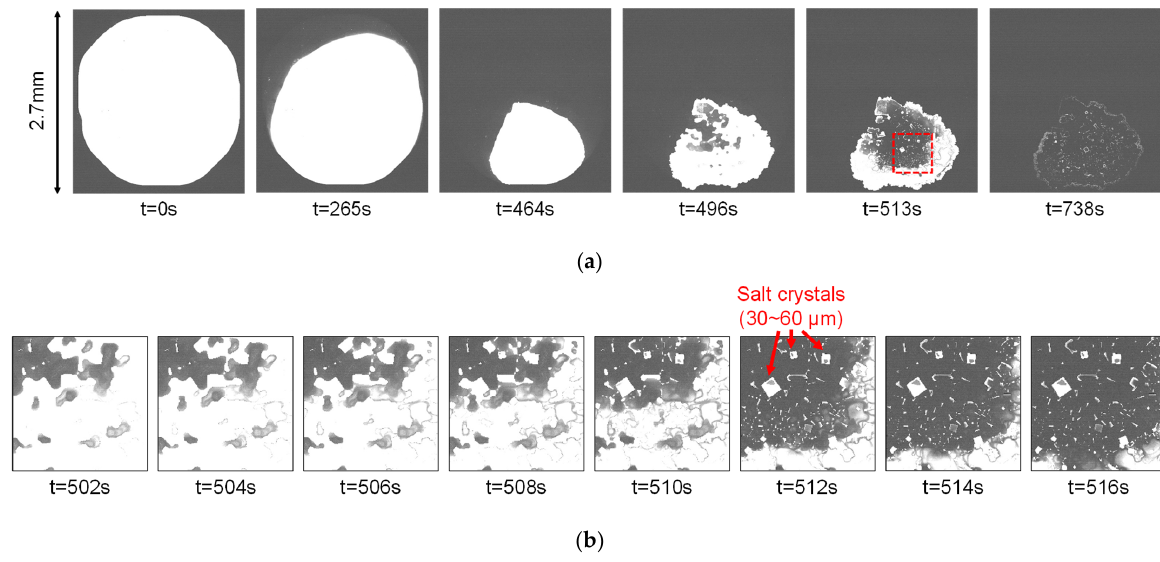
Figure 17. Captured images of a drop of saline solution on the sensor surface drying out as time advances captured by Chip B: ( a ) sample images; ( b ) closed-up images of red rectangle in ( a ).